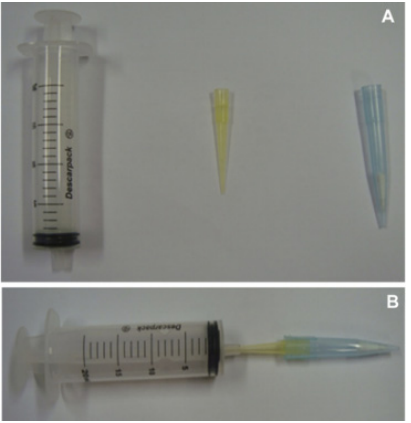
Figure 5. Apparatus employed for PT-MIP- µ -SPE. ( A ) Components of the apparatus and ( B ) appara- tus mounted